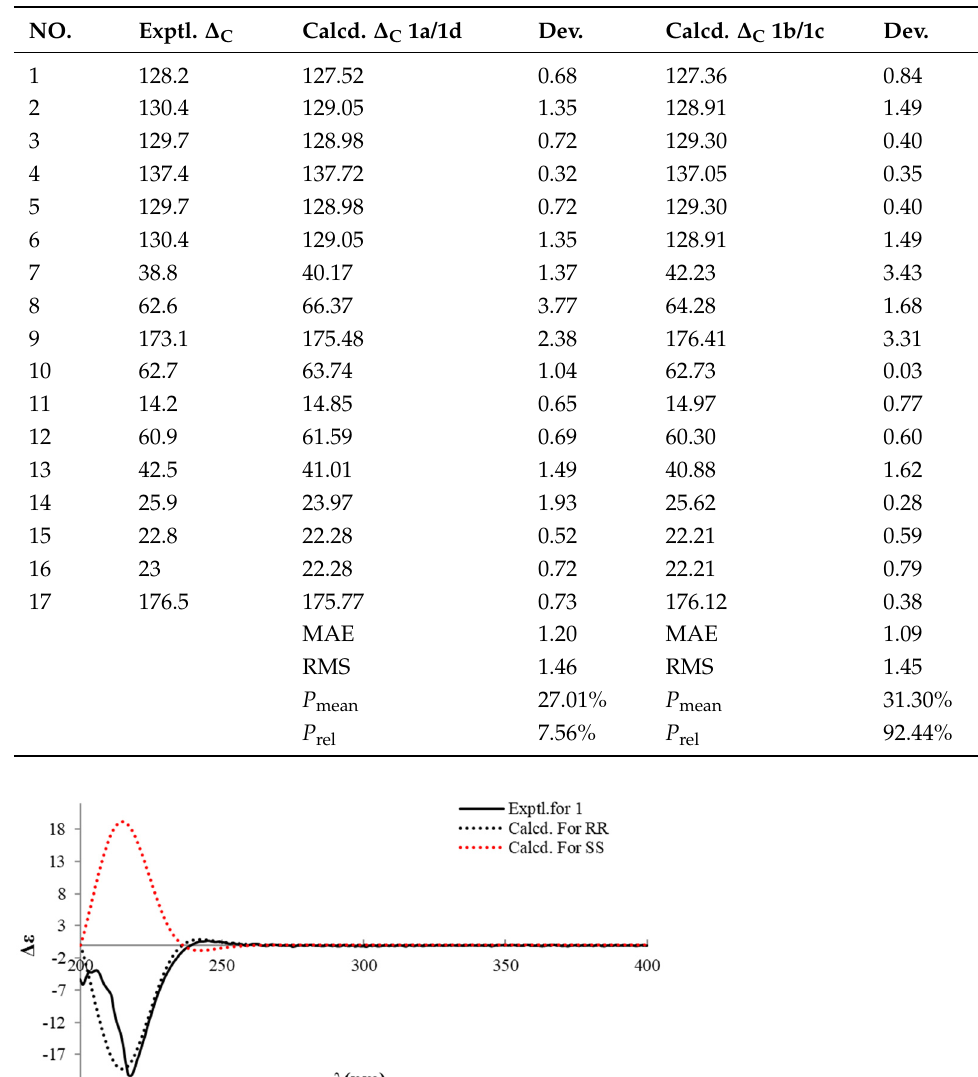
Table 2. Calculated 13 C chemical shifts of 1a – 1d fitting with the experimental data of compound 1 following STS protocol.